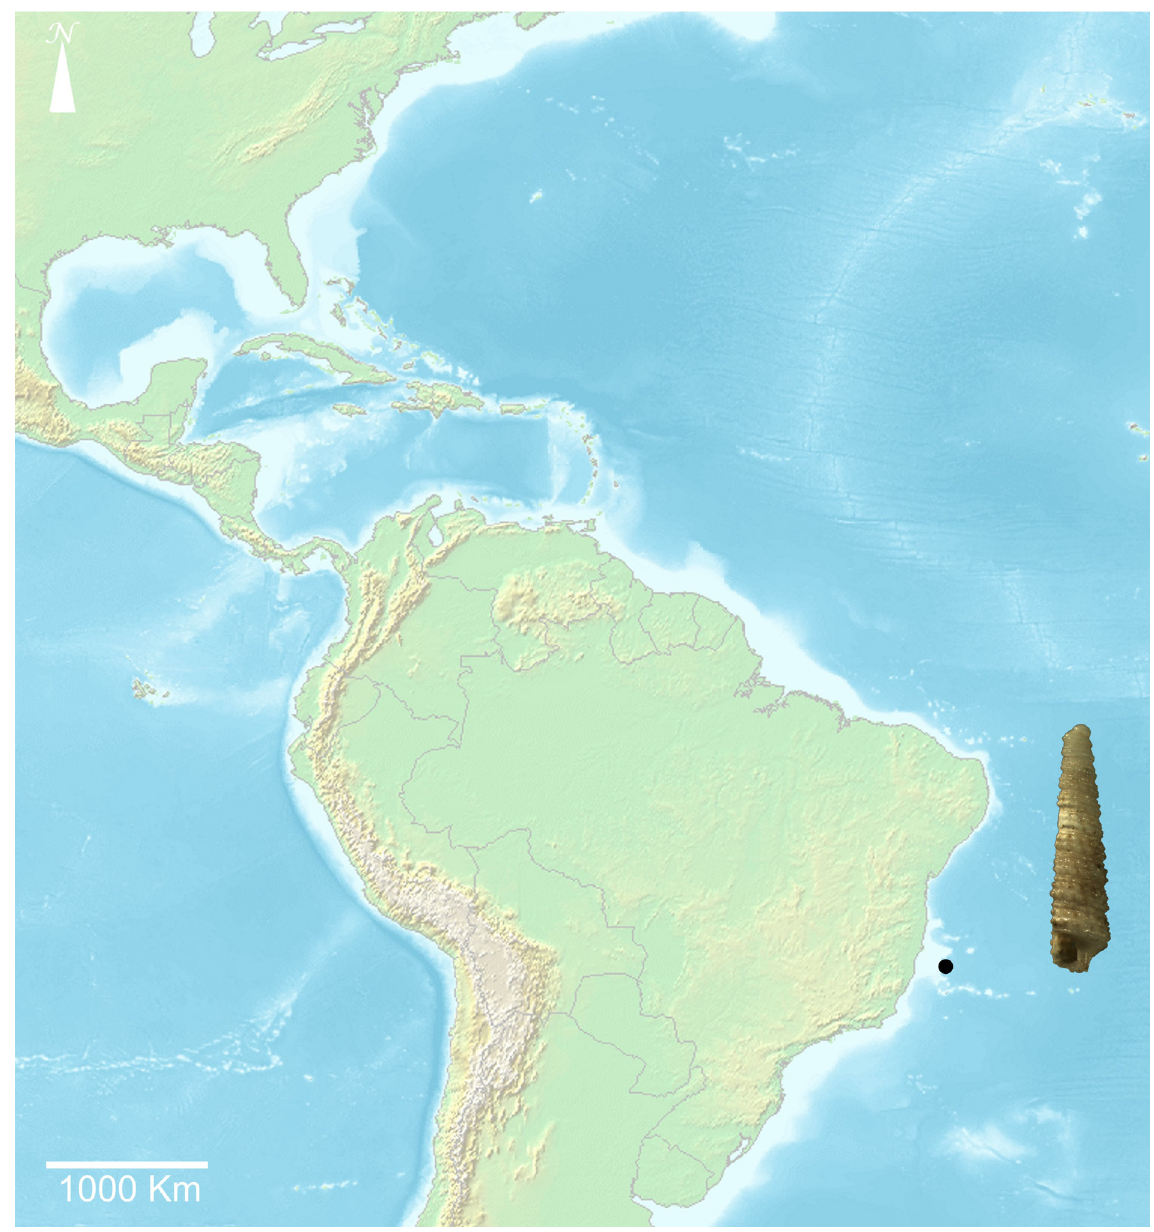
Fig. 74. Distribution map of Strobiligera sp.